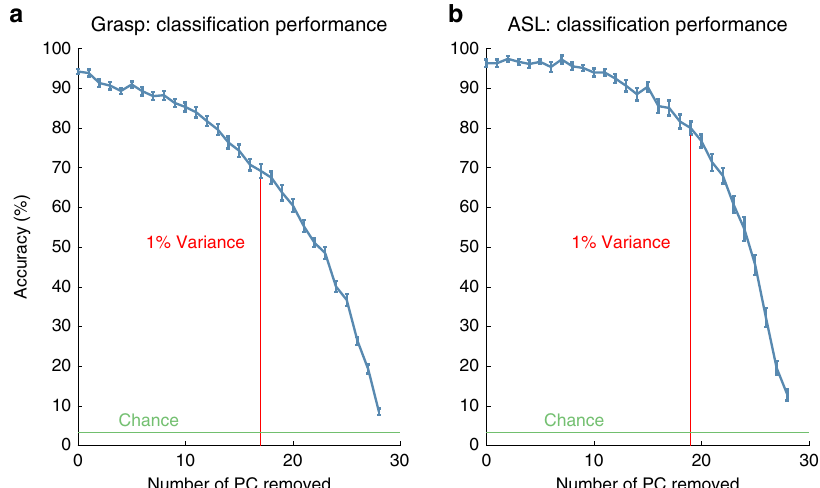
Fig. 5 Classi fi cation of condition (object, sign) based on different subspaces of kinematics. a Mean grasp classi fi cation performance after progressively removing PCs, from high variance to low. Results are averaged across eight subjects with fi ve repetitions each (random allocation of training and testing data in each repetition, see “ Methods ” section for more details). Error bars denote the SEM. b Mean ASL classi fi cation performance based on reduced kinematic subspaces, averaged across three subjects with fi ve repetitions each. Vertical red lines denote the PC beyond which the subspace accounts for <1% of the variance; error bars denote the standard error of the mean (SEM). Note that objects and letters can be classi fi ed accurately based on just a handful of high-variance PCs (Supplementary Fig. 4). Classi fi cation performance is highly consistent both across repetitions of the same subject and across subjects (note the small SEM).